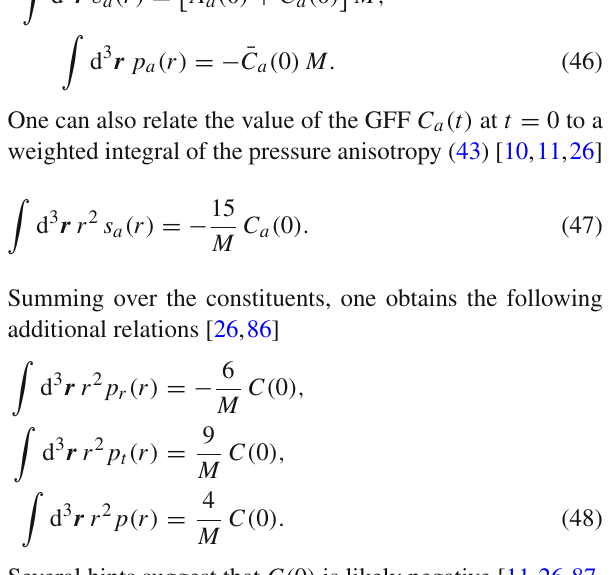
Fig. 8 Radial p r (ε) , tangential p t (ε) , and isotropic p (ε) EoS for a quarks and b gluons computed using the multipole model (11) with parameters given in Table 1, see Eqs. (34)–(37) for definitions (cid:2) (cid:25) (cid:26) ¯ A a ( 0 ) + C a ( 0 ) M , d 3 r ε a ( r ) =